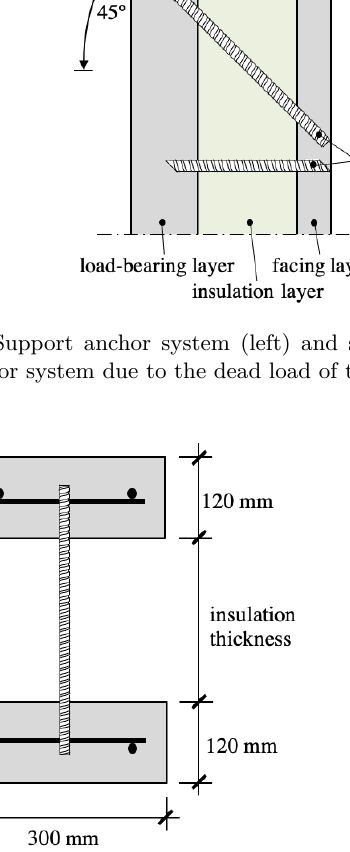
Figure 4. Geometry of the test specimens for short- and long-term tests under compression load.